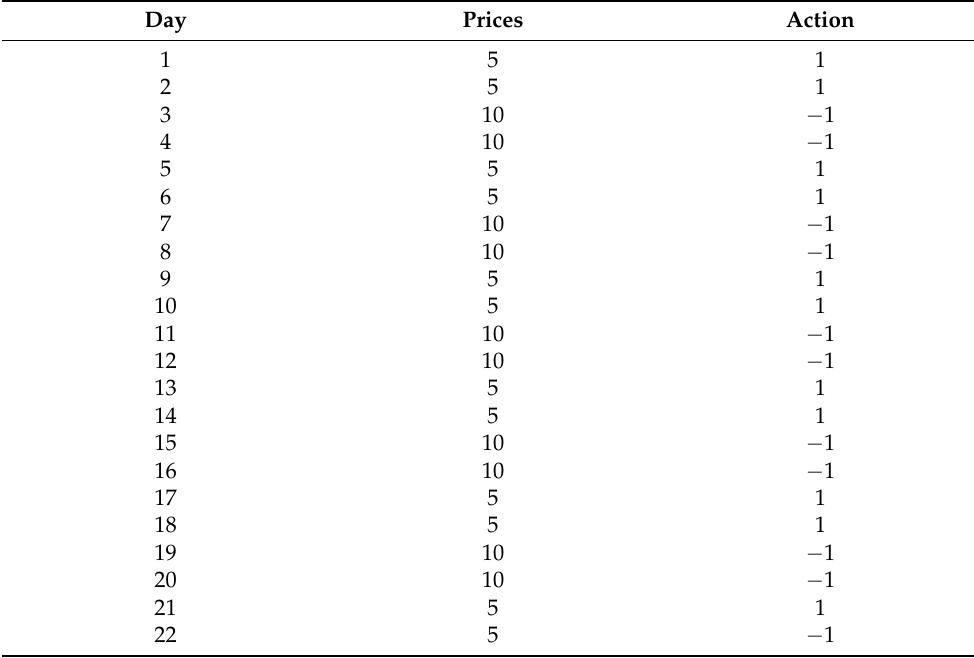
Table 1. A Hypothetical Example of a Swing